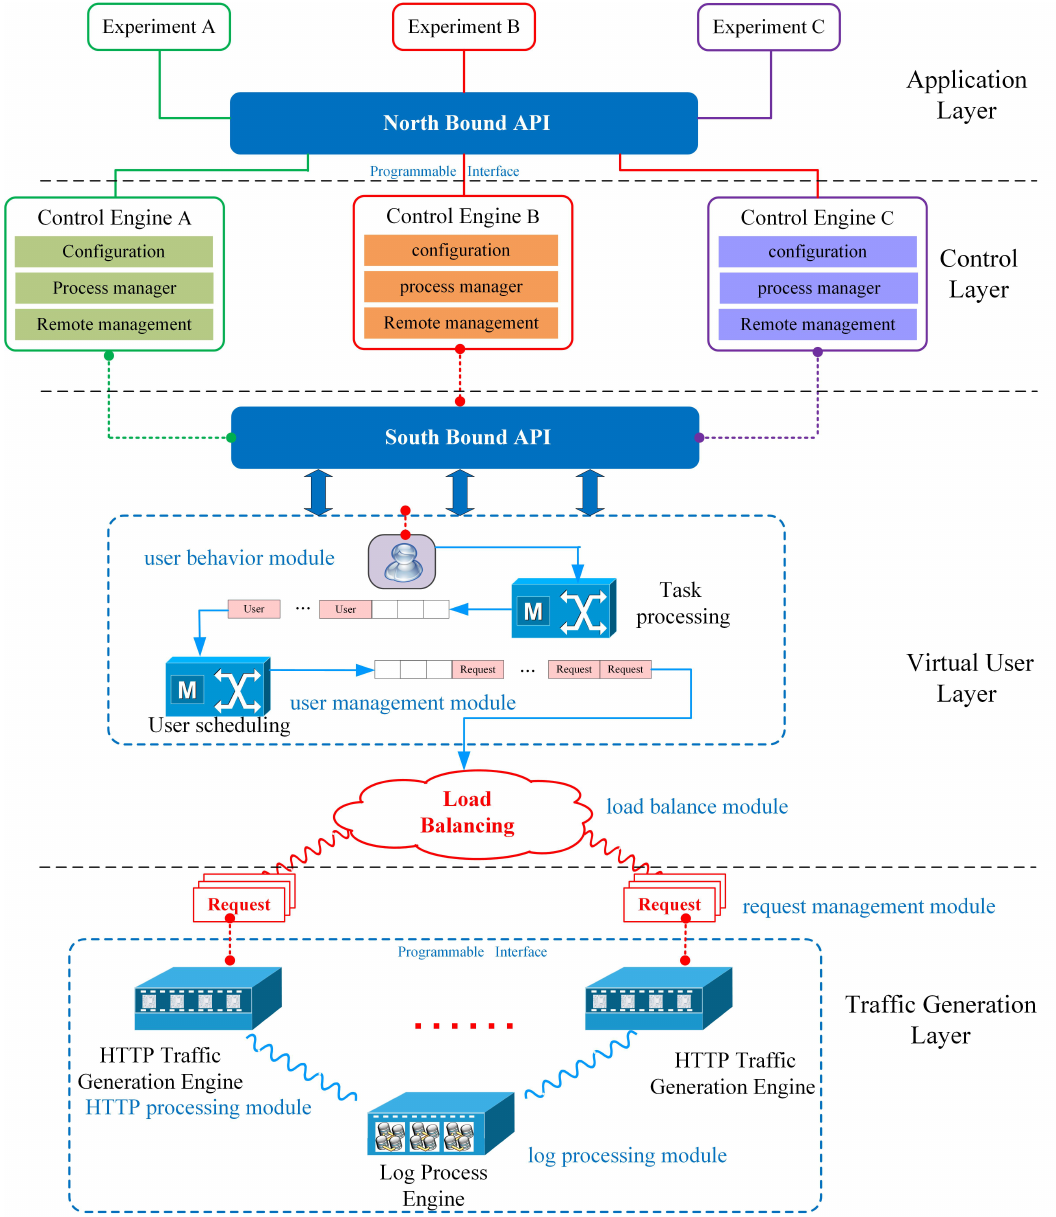
Figure 3. The layered system architecture of